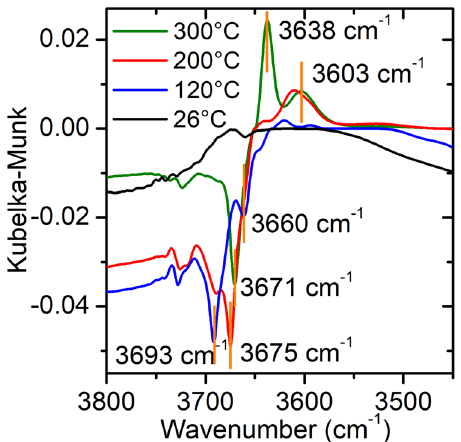
Fig. 4 DRIFTS studies of hydroxyl species on the surface of ceria support. The fi gure shows the changes of pre-adsorbed OH bands after CO was introduced at 300°C, 200°C, 120°C, and 26°C (see Methods for experimental details). Band assignments are based on previous reports: 32,33 3693cm − 1 − mono-coordinated OH (Type I) on Ce; 3675cm − 1 , 3671cm − 1 , and 3660cm − 1 − doubly bridging OH (Type II-A) on Ce; 3638cm − 1 − doubly bridging OH on Ce with oxygen vacancy in the vicinity (type II-B); 3603cm − 1 − triply bridging OH (Type III) on